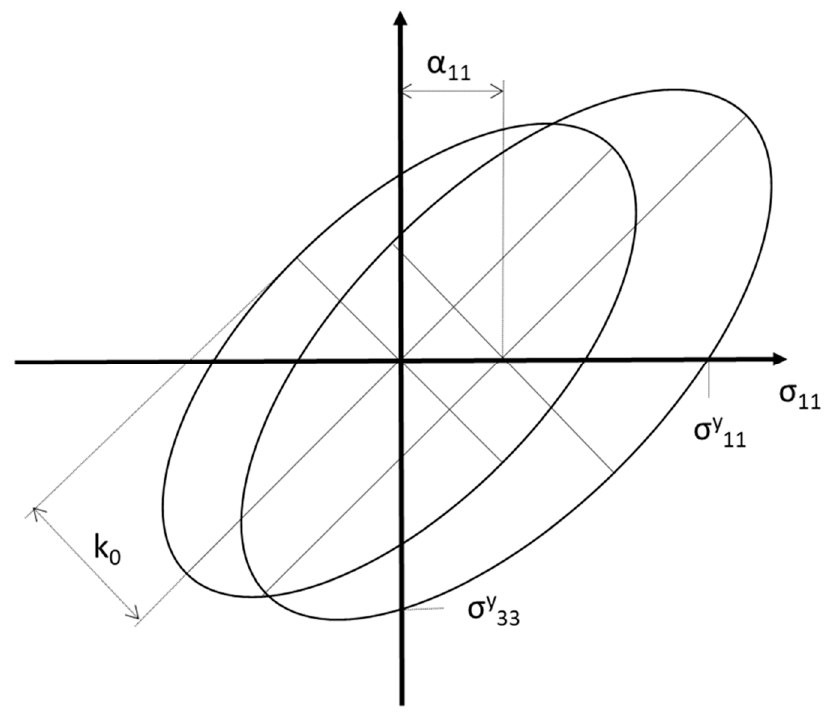
Figure 1. Graphical interpretation of the strain-hardening cross-effect for plane stress state.